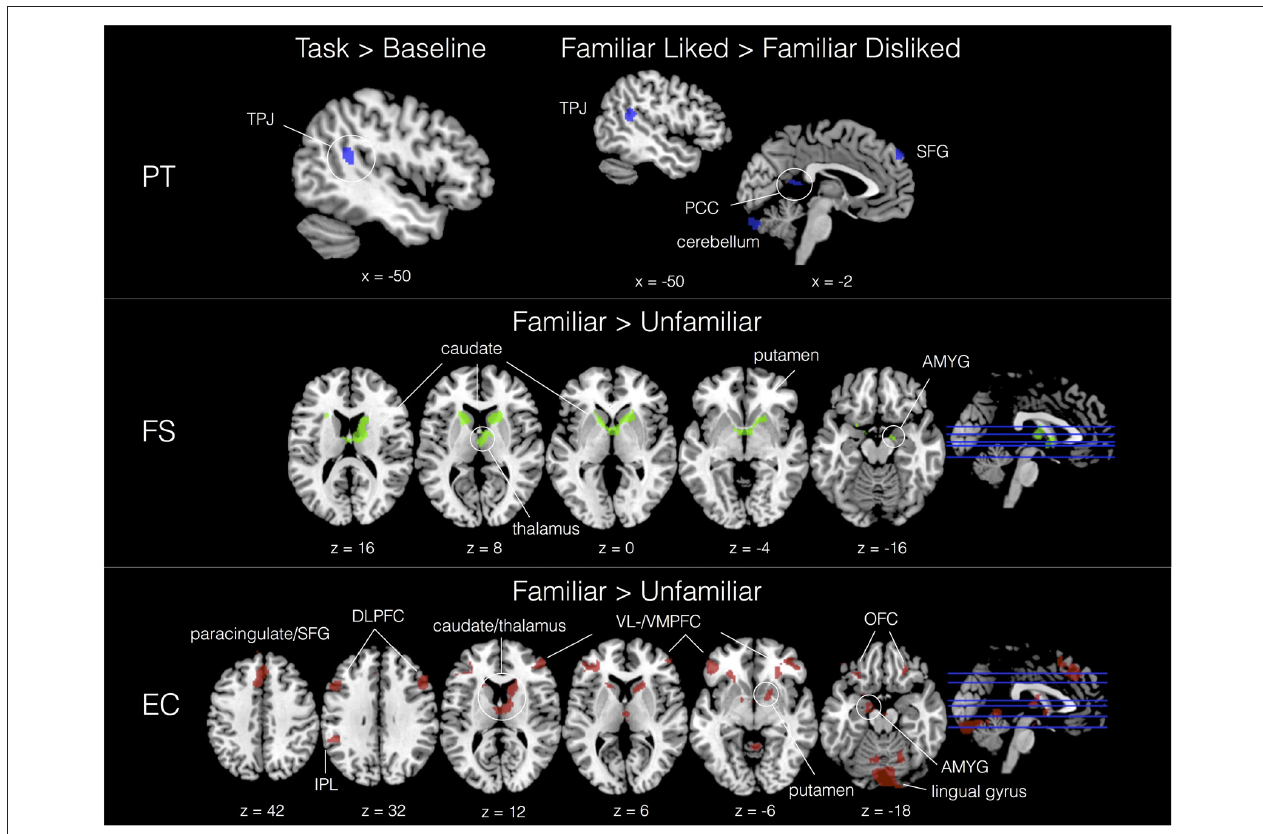
FIGURE 5 | Activation sites correlating with trait empathy (IRI subscales) in selected contrasts. PT = blue, FS = green, EC = red. All contrasts, Z > 2.3, p < 0.01 (cluster corrected, p <